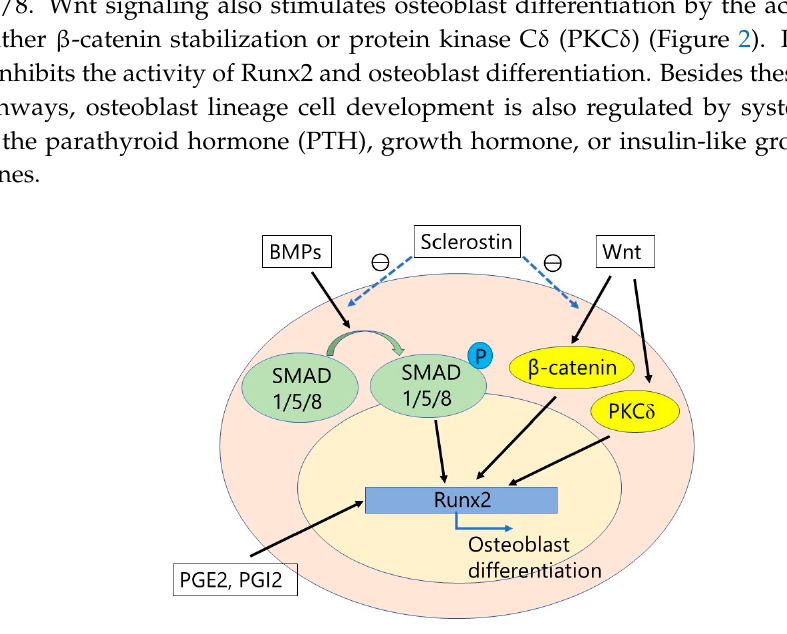
Figure 2. The integration of bone morphogenetic proteins (BMPs) and Wnt signaling. BMPs stimulate osteoblast differentiation by activation of Runx2 via SMAD proteins. Wnt signaling also stimulates osteoblast differentiation by activation of Runx2 through either β -catenin stabilization or protein kinase C δ (PKC δ ). Prostaglandins (PGs), particularly PGE2 and PGI2, also activates Runx2, which